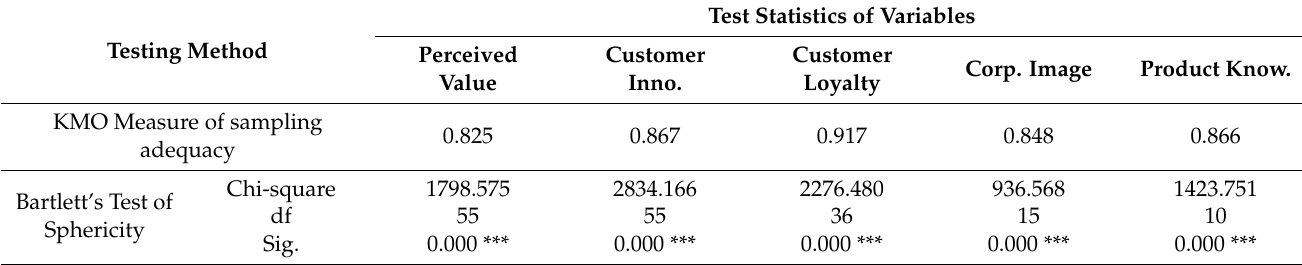
Table 3. Values of KMO and Bartlett’s test of